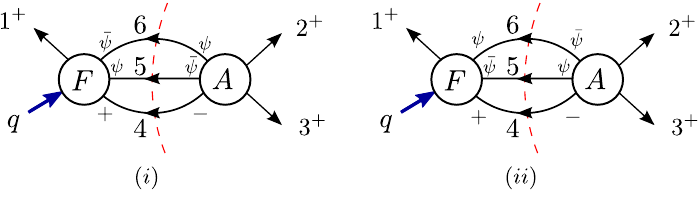
Figure 12 . Triple cut of the two-loop form factor in the s 23 -channel - fermions and a gluon running in the loop, the second possible